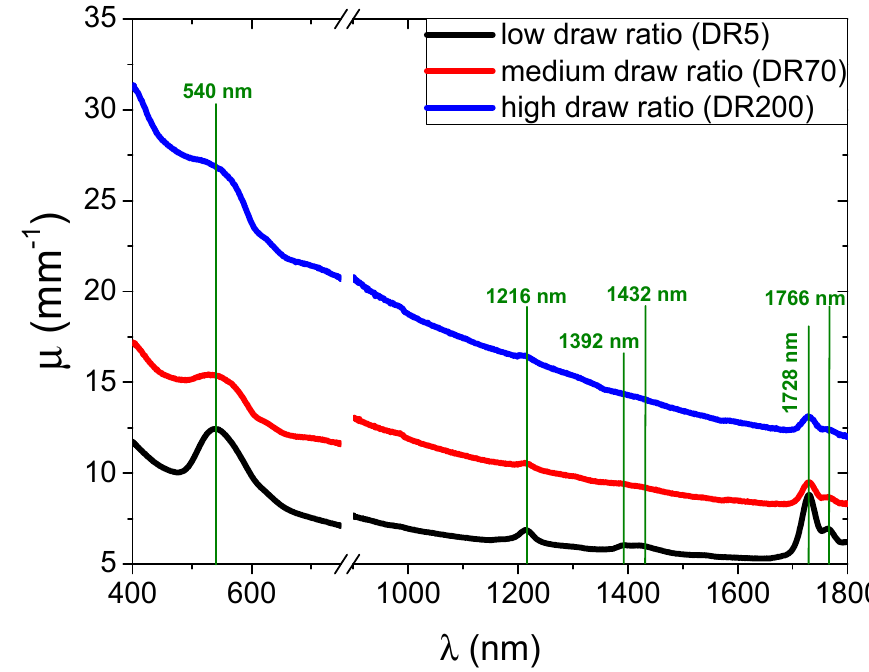
Figure 4. Linear absorption coefficient of the UHMWPE/gold nanocomposites as a function of wavelength with green lines showing relevant peaks.